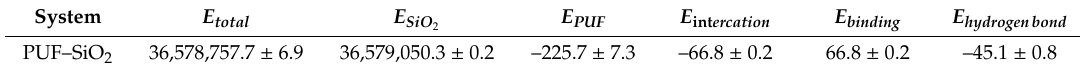
Table 4. Energies of the PUF–SiO 2 interfacial interaction (kcal / mol ± standard